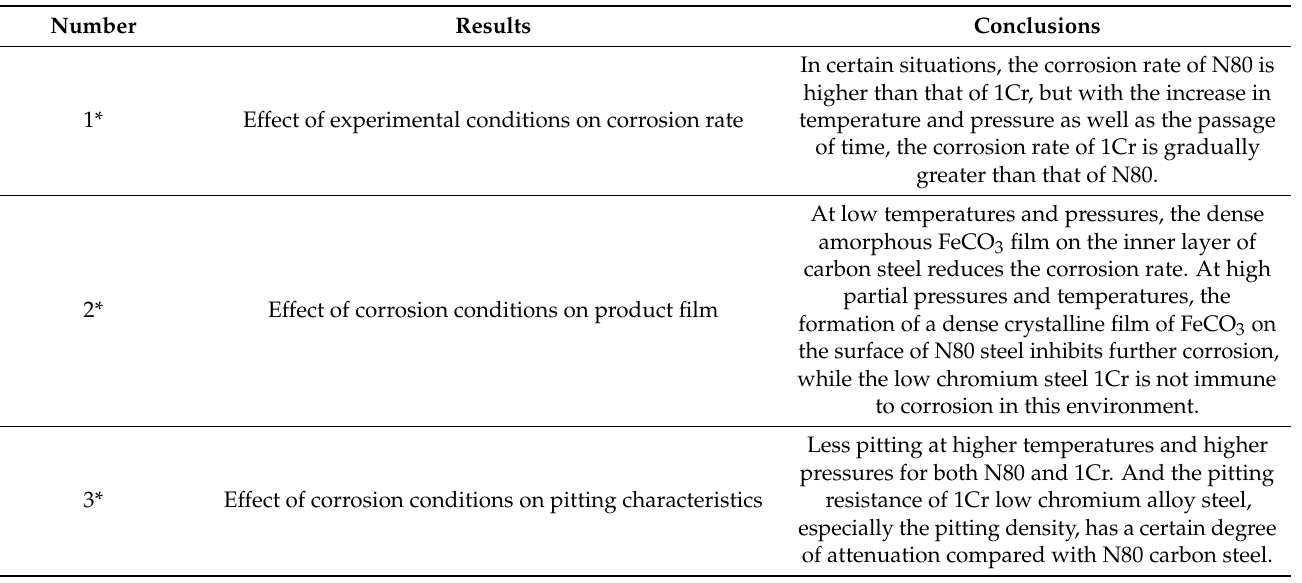
Table 7. Conclusion